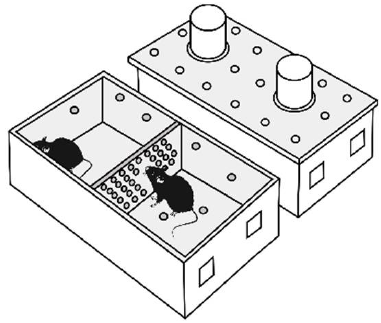
Figure 8. The experimental